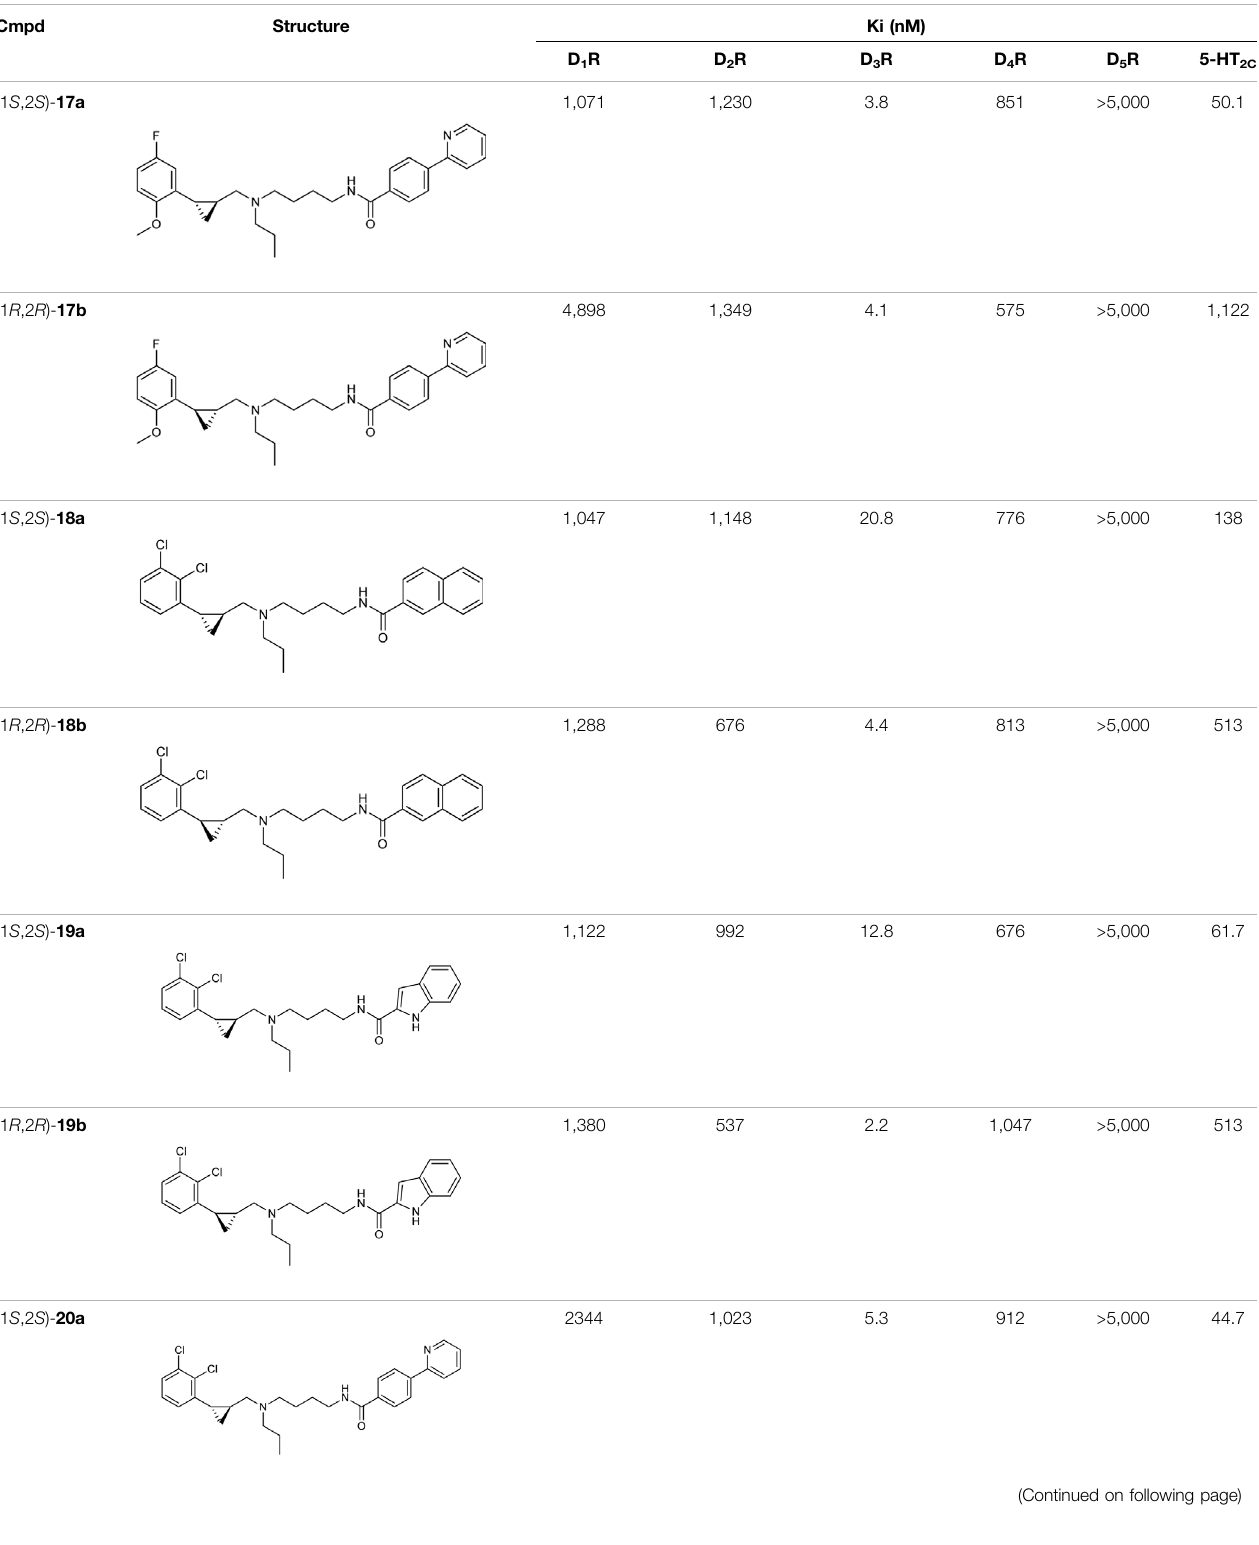
TABLE 1 | Selected compounds from DR related selectivity studies (Battiti et al., 2019; Tan et al., 2020; Lee et al., 2021).